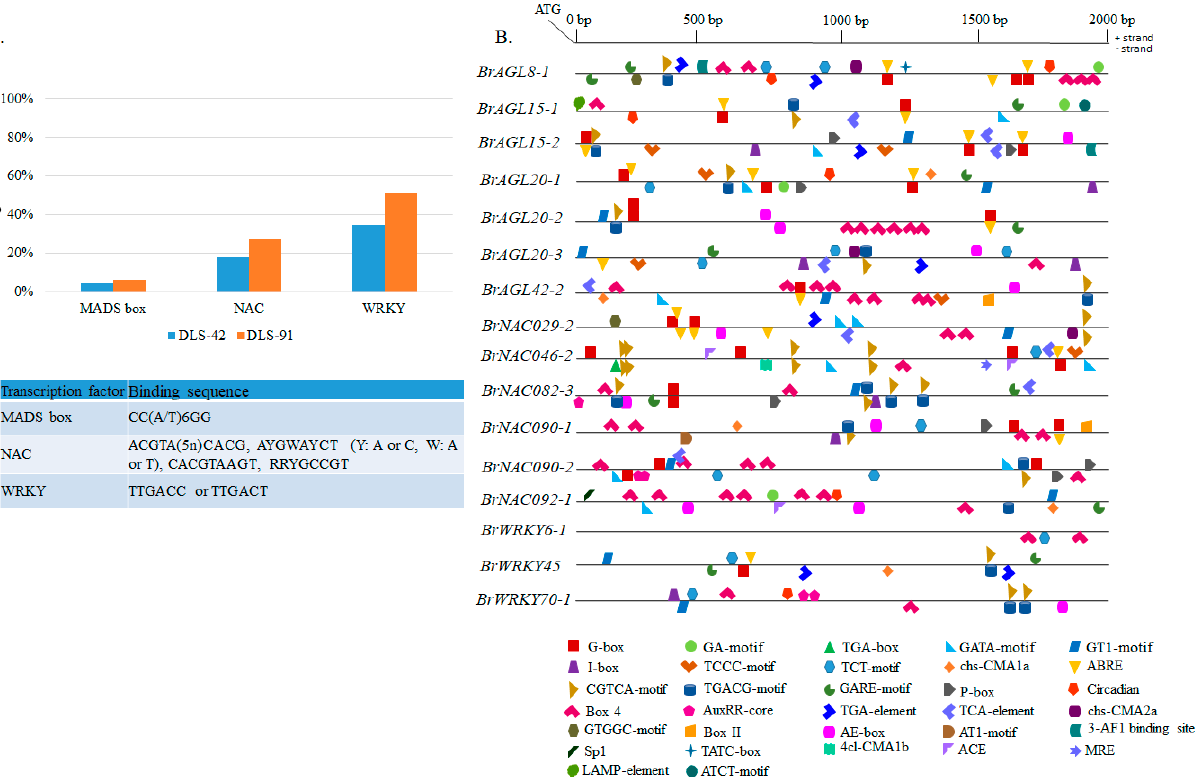
Figure 9. Prediction of cis -elements in the 2-kb upstream promoter region of differentially expressed transcription factor genes. ( A ) Proportion of differentially expressed genes from the entire transcriptome data set containing MADS, NAC, and WRKY conserved motifs. The table details the binding sequence of each cis -element. ( B ) Schematic representation of conserved motifs identified among AGAMOUS-LIKE, NAC, and WRKY differentially expressed transcription factors. Detailed information on depicted light-related, hormone-related, and other conserved motifs is provided in Tables S12 and S13.